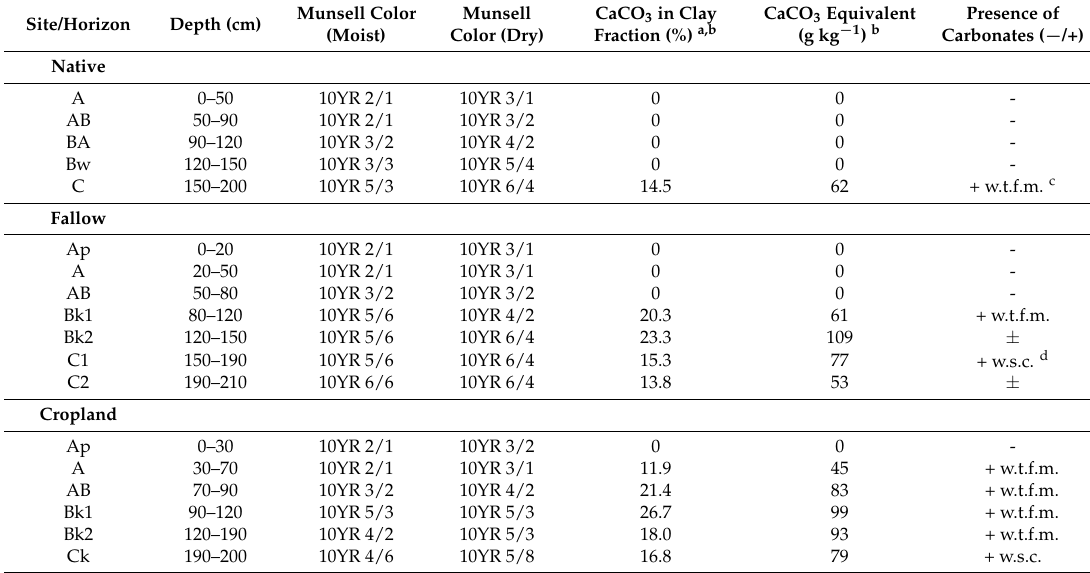
Table 3. Selected soil properties with depth and site relevant to horizon differentiation in the representative soil profile (adapted from